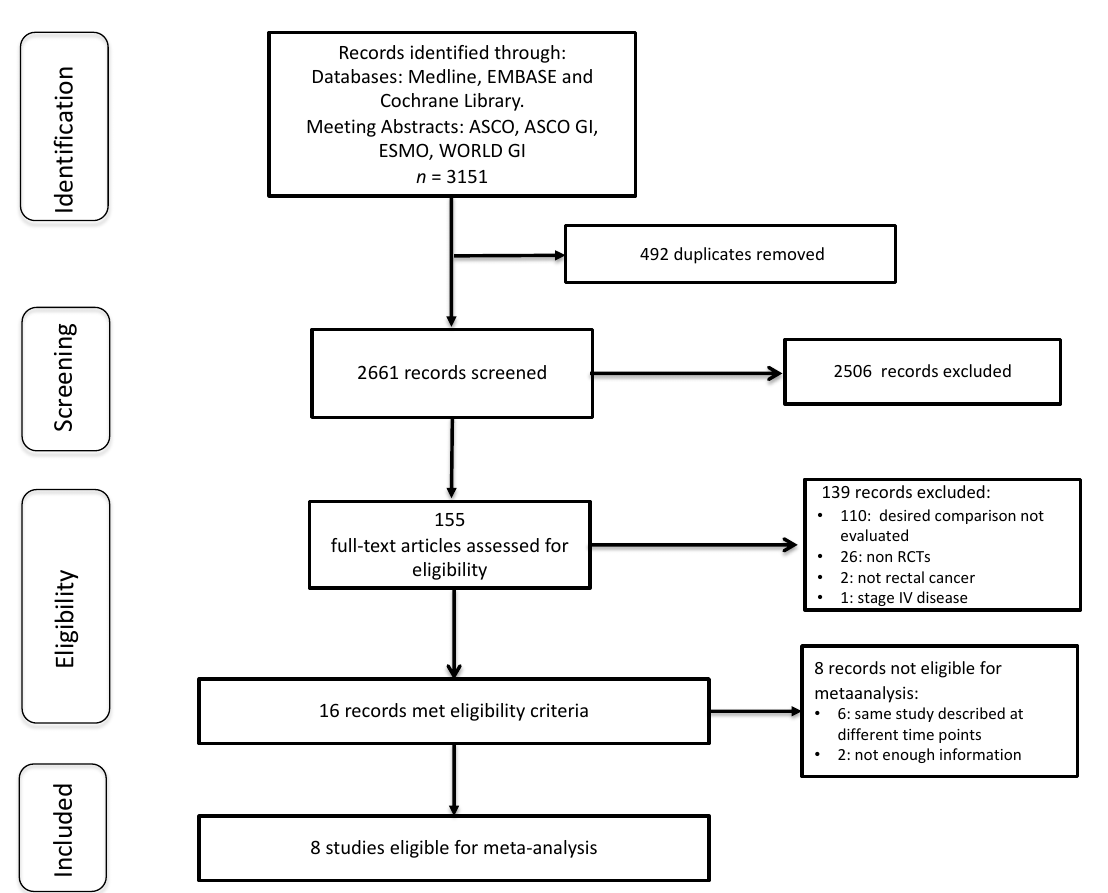
Figure 1. Flow chart showing study